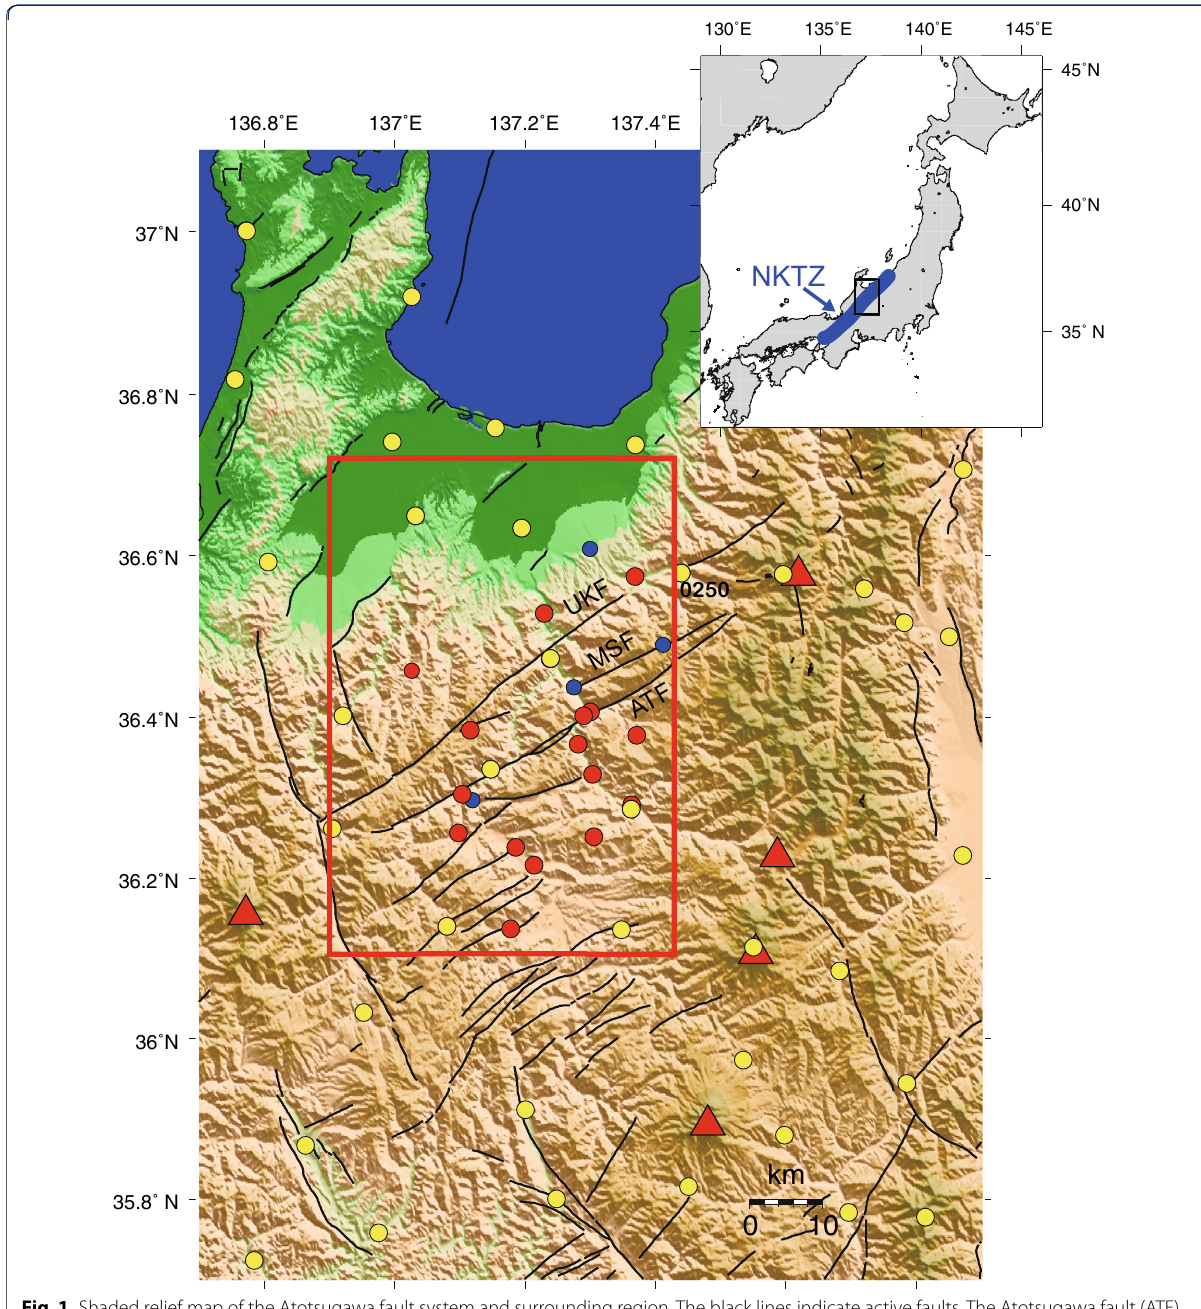
Fig. 1 Shaded relief map of the Atotsugawa fault system and surrounding region. The black lines indicate active faults. The Atotsugawa fault (ATF), Mozumi–Sukenobu fault (MSF), and Ushikubi fault (UKF) comprise the Atotsugawa fault system. Yellow circles indicate GEONET stations. Red circles indicate our GNSS stations used for correcting the interferograms. Blue circles indicate our GNSS stations not used for corrections. GEONET station 0250 was used as the reference. The red frame indicates the area shown in Figs. 5 and 7. Active volcanoes appear as triangles. The inset shows the location of the study area (black frame) within the Japan arc. The blue line indicates the Niigata-Kobe Tectonic Zone